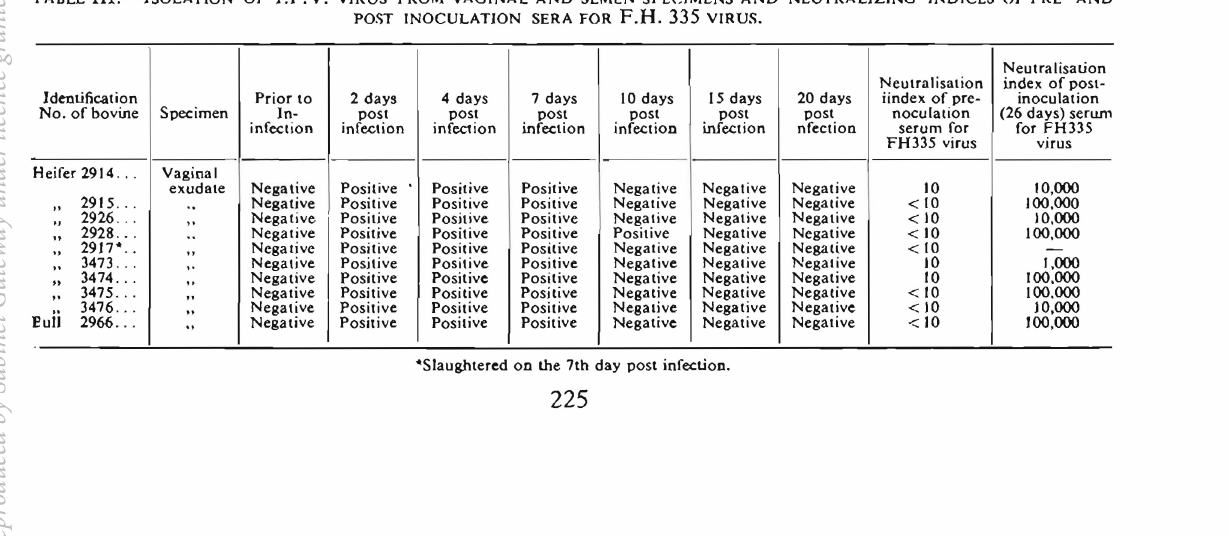
TABLE IlL-ISOLATION Of I.P.V. YlRUS FROM VAGINAL AND SEMEN SPEr.IMENS AND NEUTRALIZING INDICeS OF PRE- AND POST INOCULATION SERA FOR F.H. 335